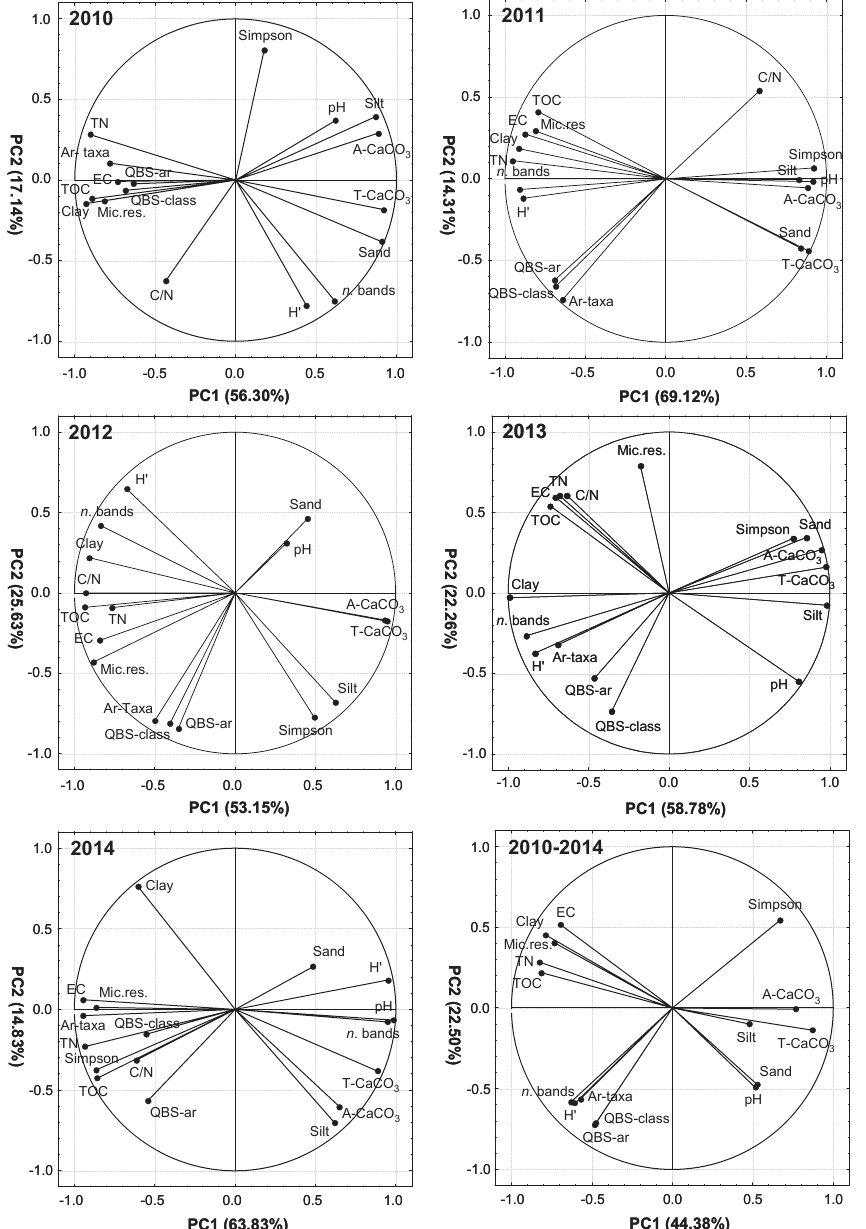
Figure 9. PCA loading plots for each year and for the whole study period (not including climate).